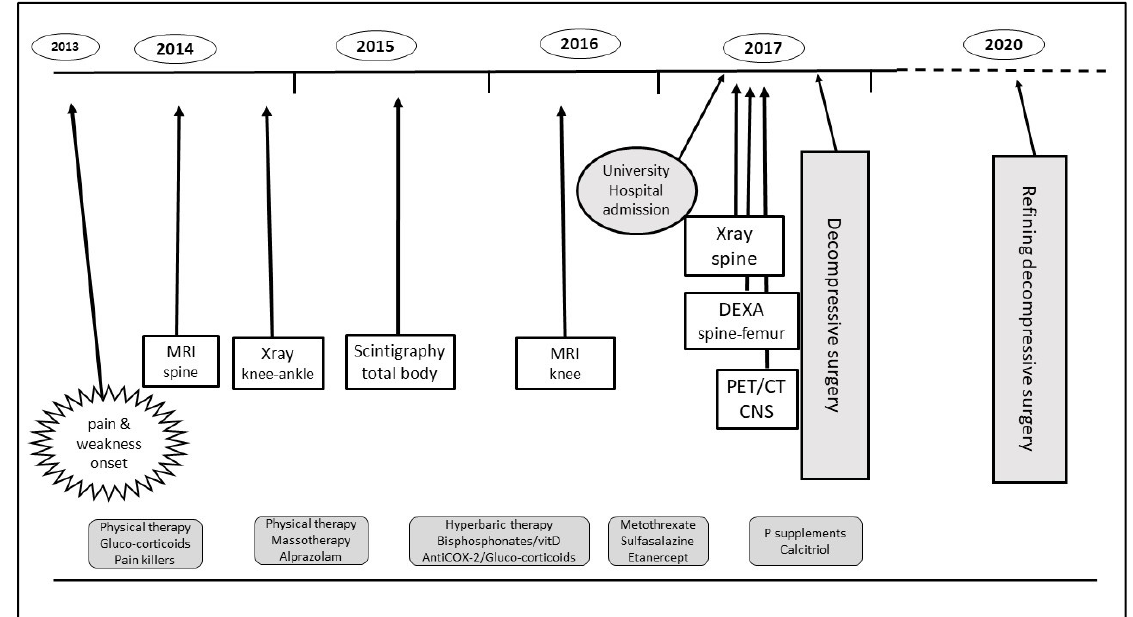
Figure 5. The timeline of Oncogenic osteomalacia (OO) diagnosis and patient management. CNS: central nervous system; DEXA: dual emission X-ray absorptiometry; MRI: magnetic resonance imaging; PET/CT: positron emission tomography/computed tomography.